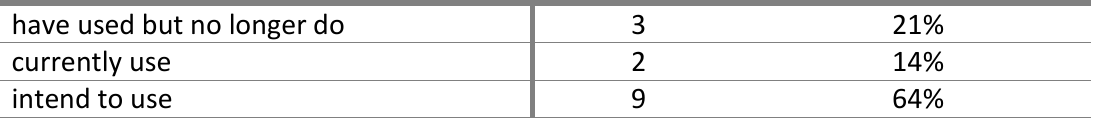
Table 26: Apprenticeships responses to question "which of the following do you use, have used or intend to use for staff training and development?" n